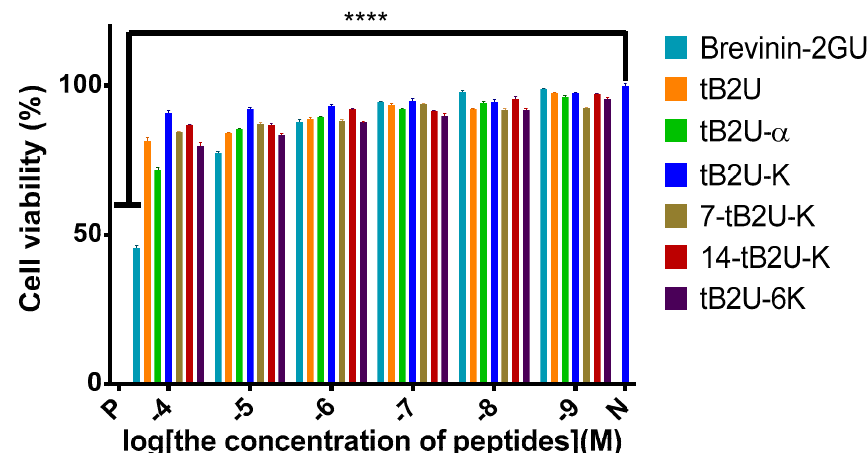
Figure 5. The cytotoxicity of Brevinin-2GUb and its designed derivatives on HaCaT. N represents the negative control and P represents the positive control, which is PBS and 0.1% Triton X-100 in this experiment, respectively. The results were analysed by two-way ANOVA and Dunnett’s multiple comparisons test compared the cell viability of different concentrations of peptides with that of the negative control. The significance (Table S2) is indicated by ****, which means p < 0.0001. The error bar represents the SEM of the nine replicates from three independent tests. Table 4. The IC 50 of Brevinin-2GUb and its analogues against HaCaT cells 1 . Normal Cell Lines